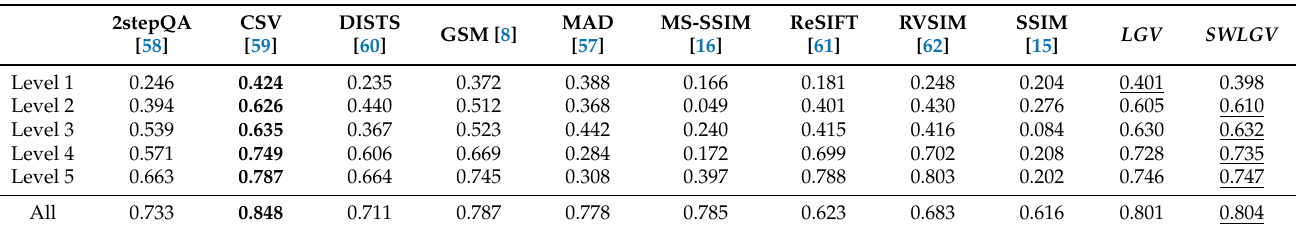
Table 5. Comparison of SROCC of each FR-IQA metrics on TID2013’s [3] distortion levels (Level 1 represents the lowest level of degradation, while Level 5 represents the highest one). The highest values are typed in bold , while the second highest ones are